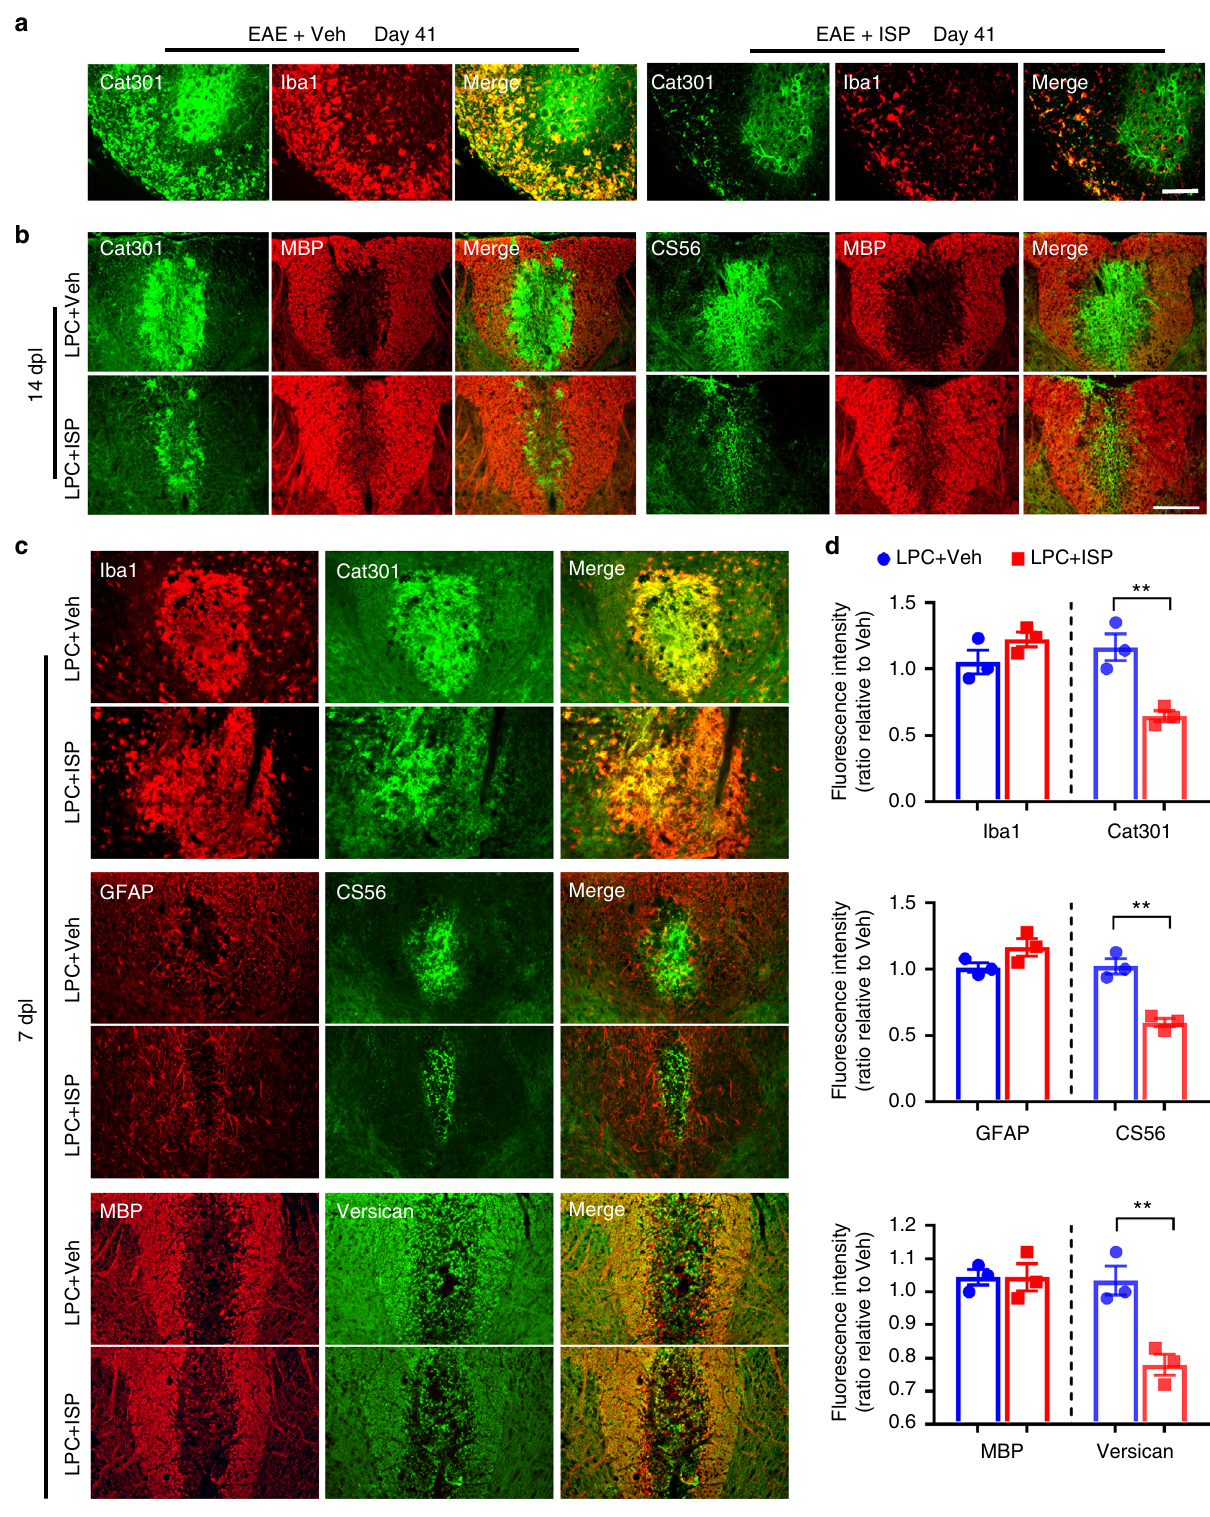
(rather than a 1 day delay) upon LPC injection, mice received ISP (20 μ g day/mouse, subcutaneous) for 7 days. Staining of the lesion epicenter revealed no change in the amount of activated microglia (Iba1), reactive astrocytes (GFAP), or MBP myelin protein expression between ISP-treated animals and control groups